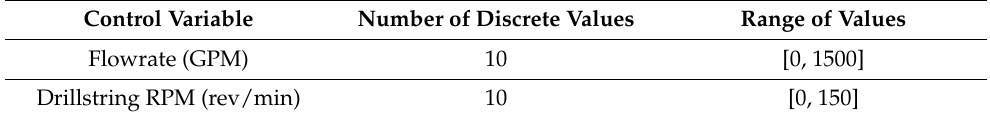
Figure 22. Progression of the rewards associated with 𝑎 𝑠𝑒𝑞1 .